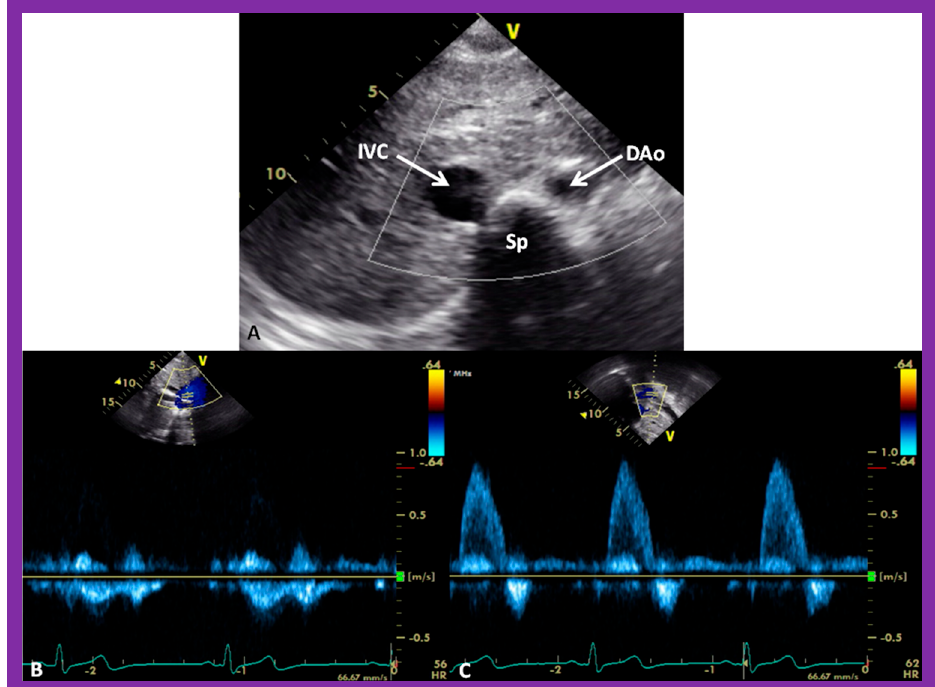
Figure 26. Selected video images secured in a short axis echo view of a normal child, illustrating the positions of the aorta (Ao) on the left side of the spine (Sp) and the inferior vena cava (IVC) on the right side of the Sp. ( A ) The IVC is generally larger than the Ao. ( B , C ) demonstrate Doppler flow characteristics with low-velocity venous flow in the IVC ( B ) and a higher velocity arterial flow in the Ao ( C ). These data are indicative of situs solitus. Reproduced from reference [4].